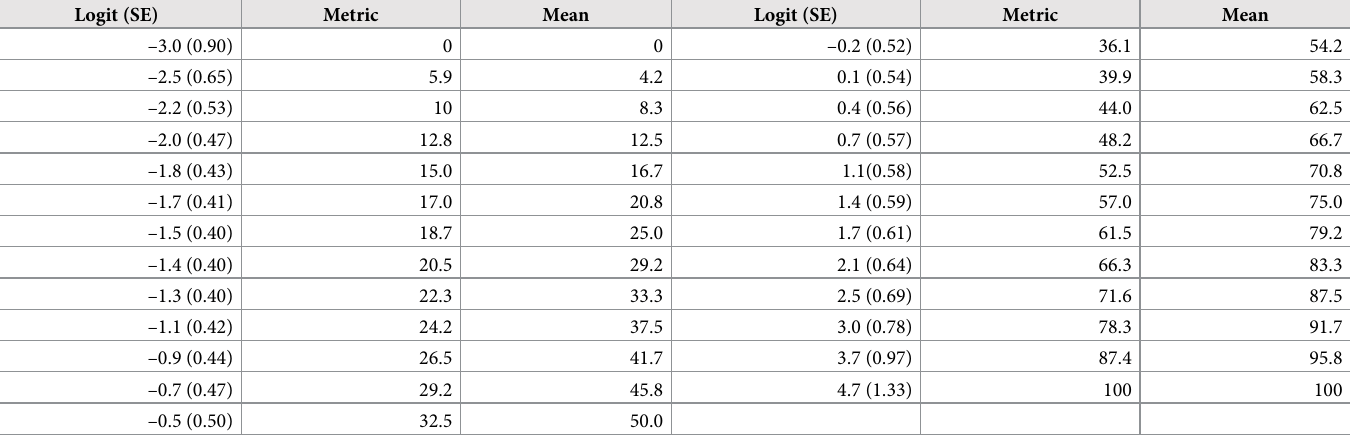
Table 6. Conversion table. Conversion table with interval scale in logit and metric (linearly transformed logit into 0–100 range) on the COPSOQ III Workplace Social Capital scale and their corresponding ordinal scale (mean) equivalents based on Rasch analysis with two testlets, n = 1316. Logit